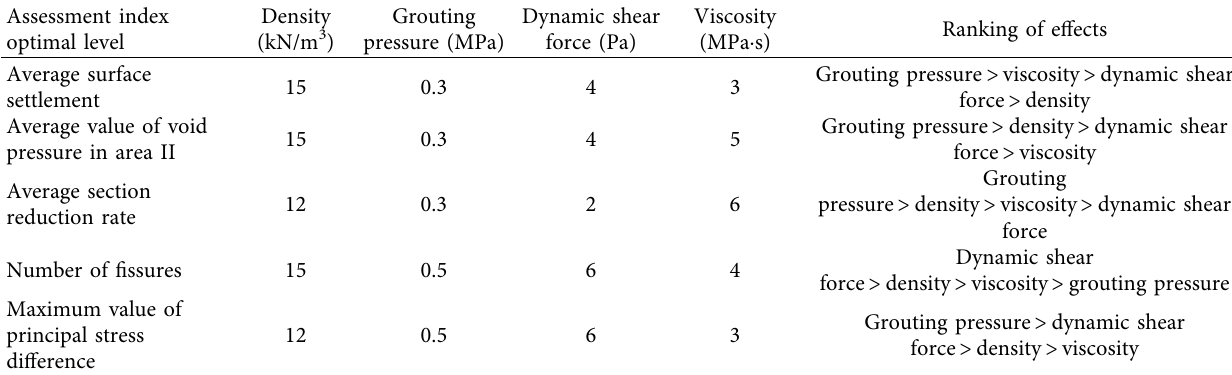
Table 5: Optimal factor level